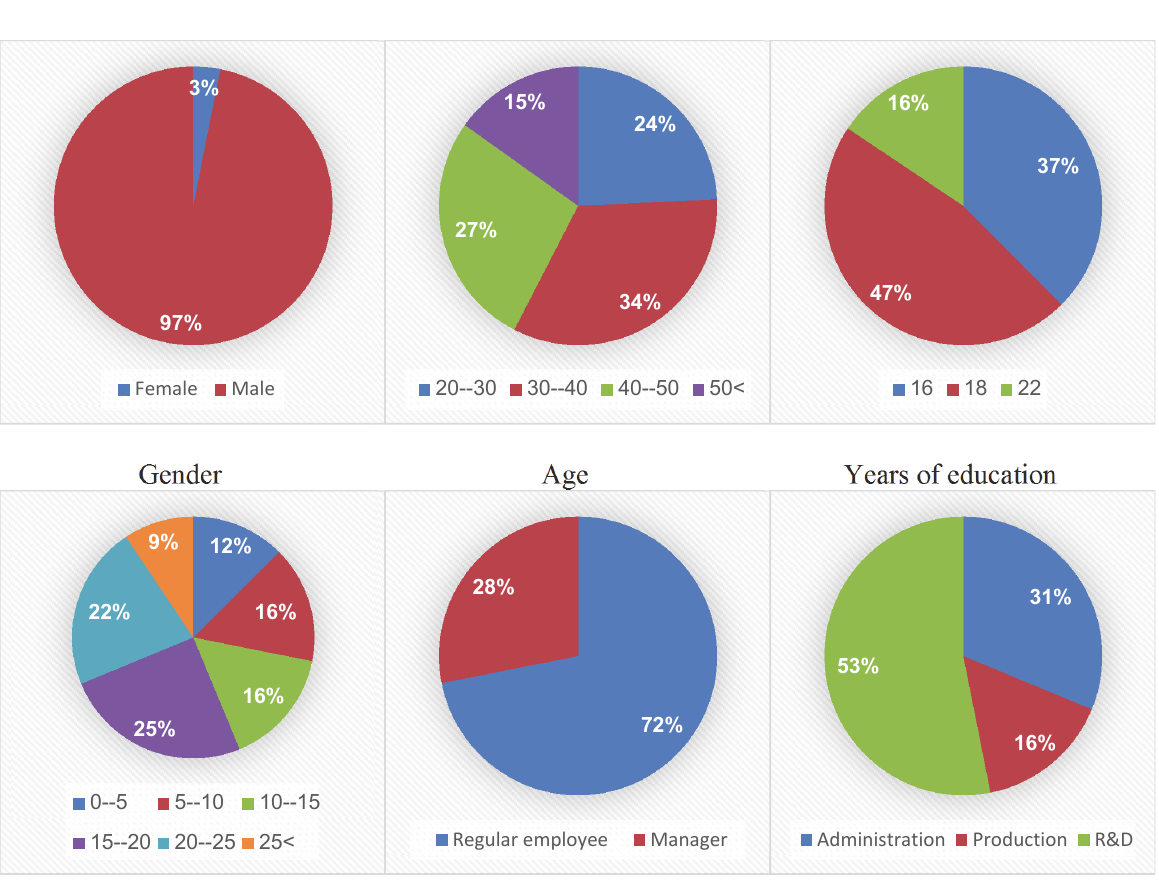
Fig. 1. Personal characteristics of the participants